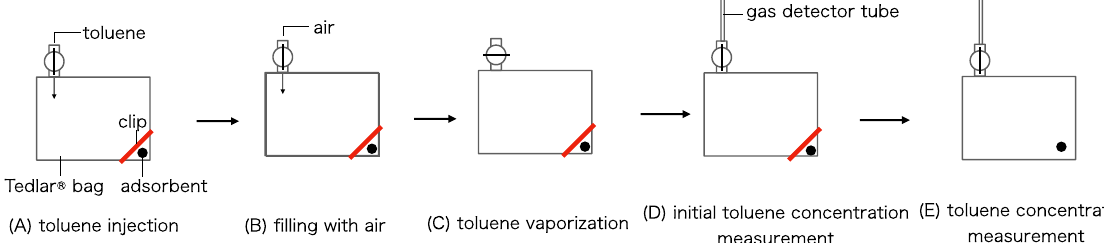
Figure 2. Experimental procedure for toluene adsorption test.